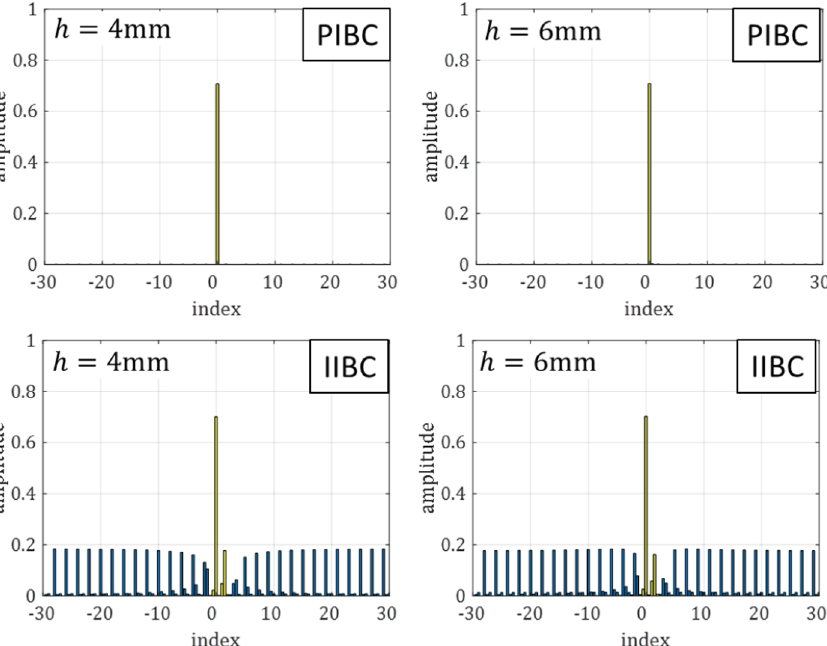
Fig. 7. Amplitude of the Floquet wave spectrum of the re fl ected electric fi eld for different heights of the dielectric with a permittivity of the dielectric of e r ¼ 2 : 5 for an TE-polarized incident wave at u i ¼ 0 ° and a TM-polarized re fl ected wave at u r ¼ (cid:3) 60 ° for: (top) the PIBC solution in (5) and (bottom) the PIBC obtained by removing from the IIBC in (4) the contribution of the grounded slab evaluated at the incidence